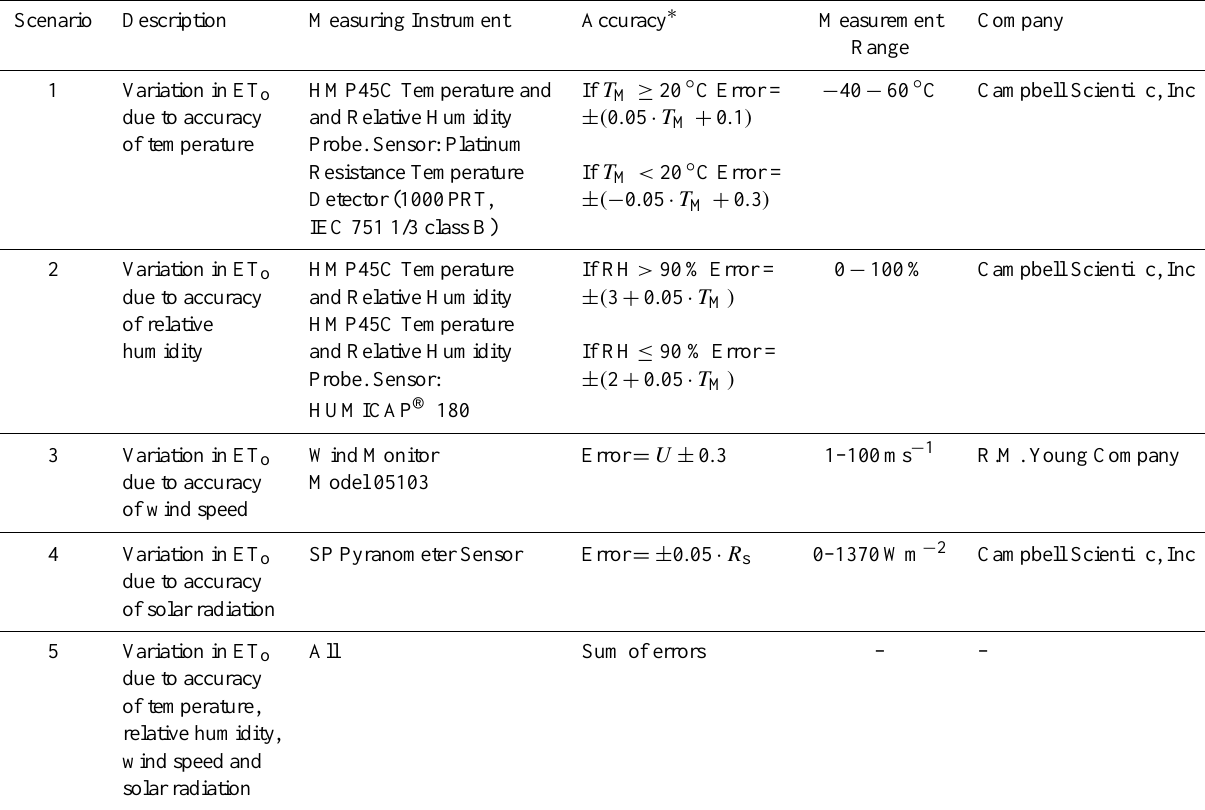
Table 3. Scenarios considered in this study representing uncertainties in the meteorological variables and the estimation of ETo. Accuracy according to Campbell scientific (2012) and R.M. Young Company